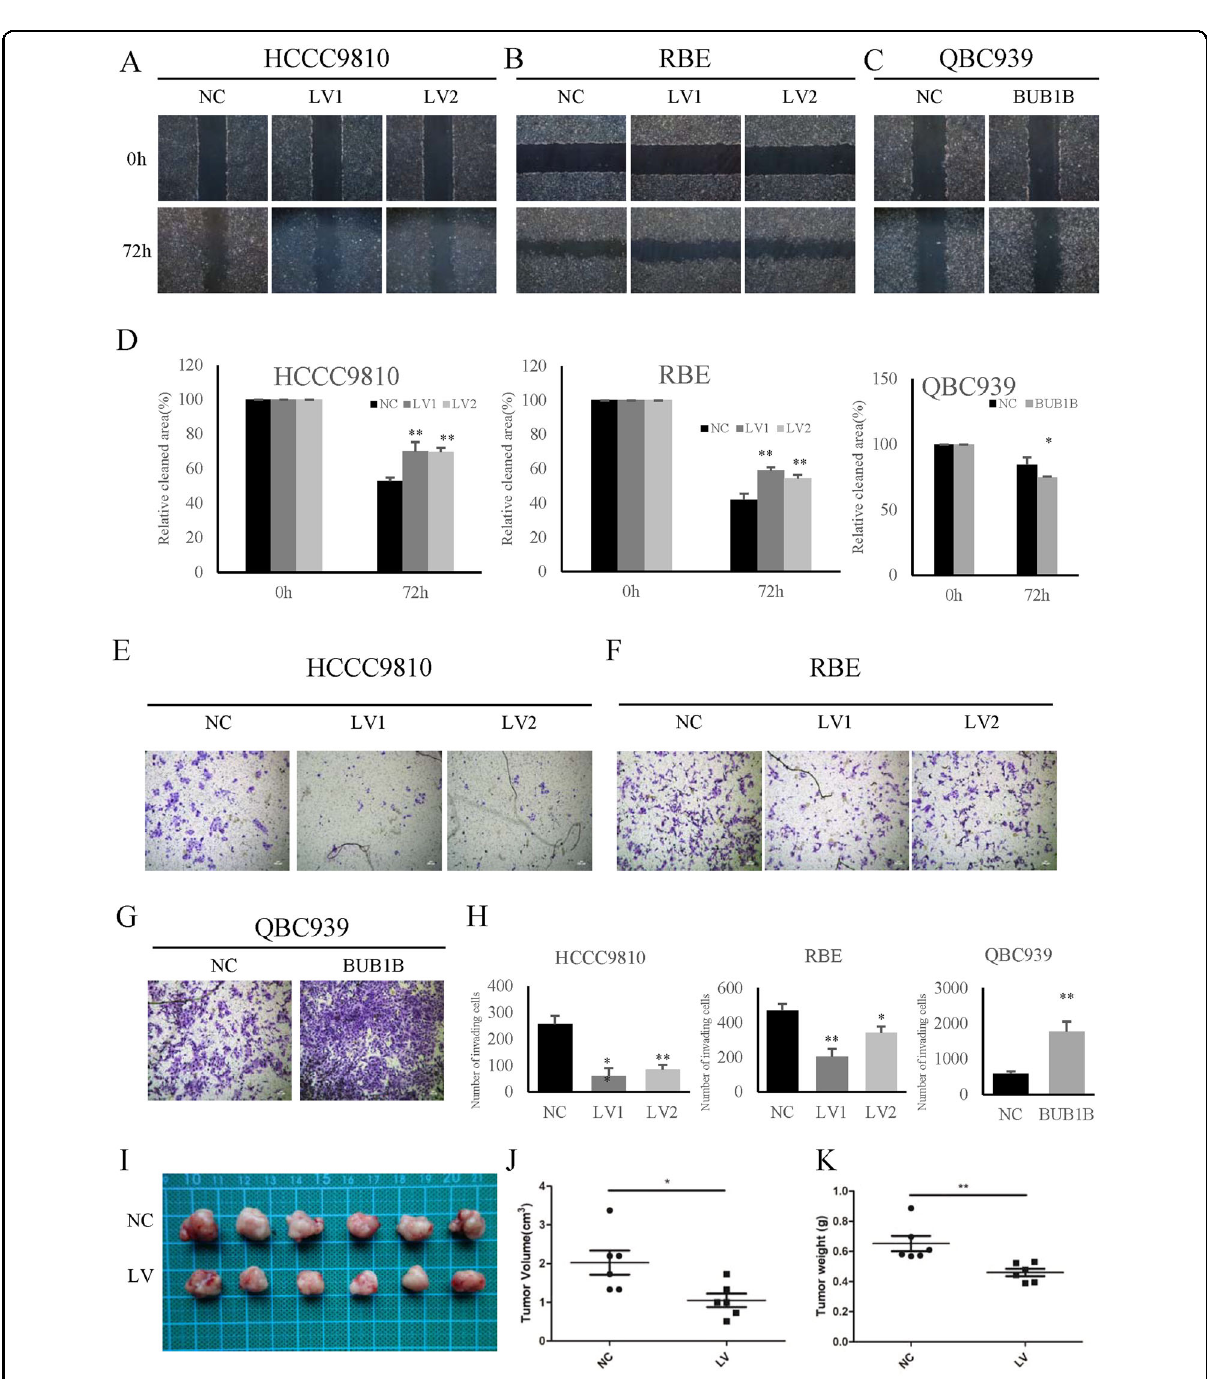
Fig. 3 BUB1B promoted the invasiveness and tumorigenicity of CAA cells. A – D The knockdown of BUB1B inhibited the migration of CCA cells, while overexpression of BUB1B contributed to tumor cell migration in wound-healing assay. E – H In the transwell assay, the invasiveness of CCA cells was inhibited after knockdown of BUB1B and was enhanced in the overexpression group, respectively. I -- K A subcutaneous xenograft tumor model in nude mice to determine the effect of BUB1B on tumorigenicity. The knockdown of BUB1B were able to suppress tumorigenicity resulting in obvious reduction in tumor volume ( J ) and weight ( K ) compared to the control group ( N = 6) (* p < 0.05; ** p <